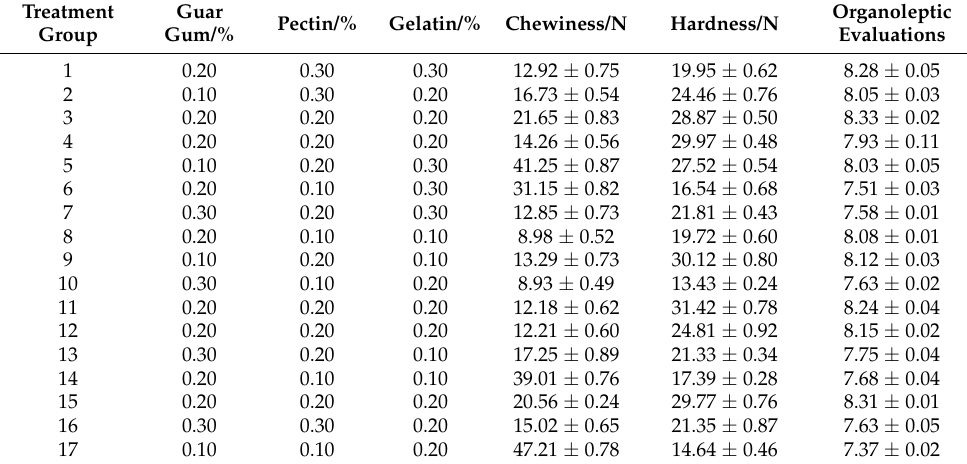
Table 3. Experimental design of Box–Behnken in the response surface